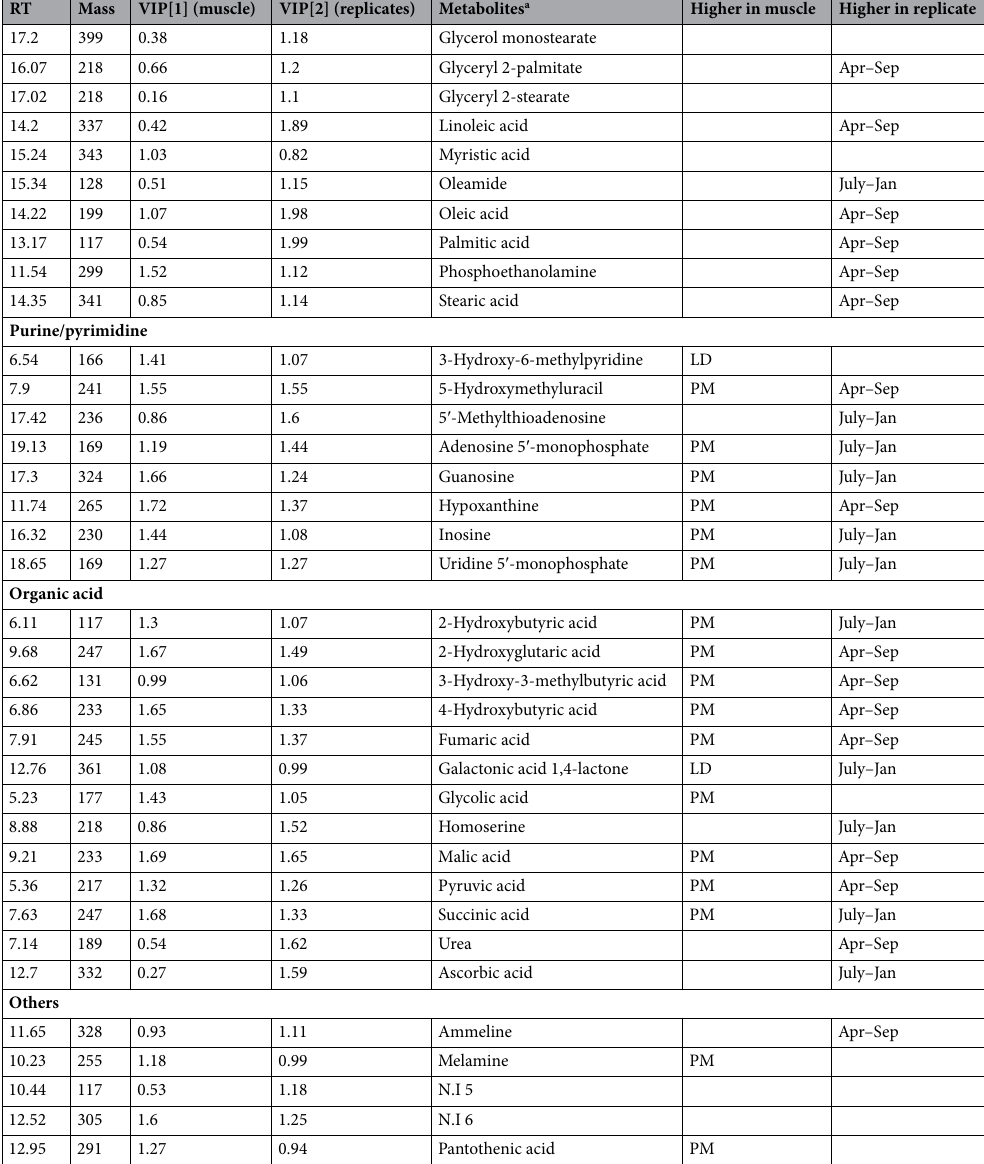
Table 2. Differentially presented metabolites in LD vs. PM with two production replicates. a Metabolites showing significant differences (VIP > 1 and P < 0.05) between muscles and production